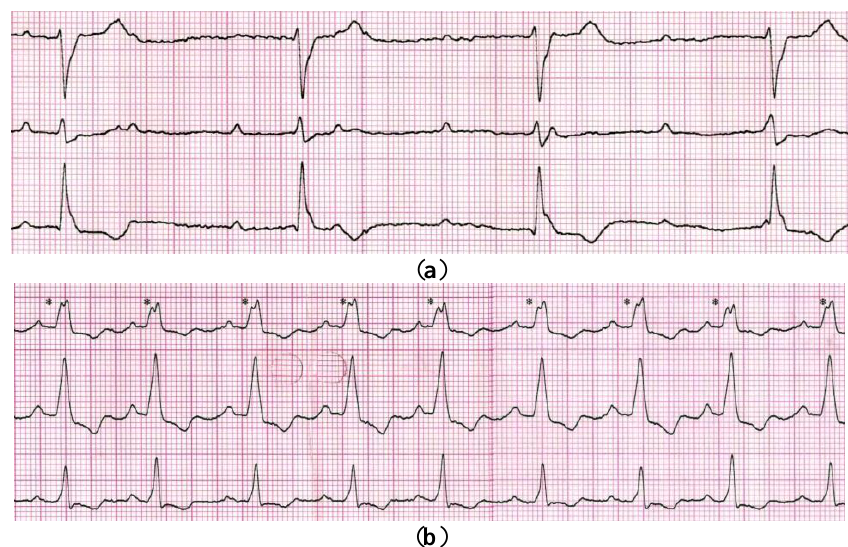
Figure 1. Electrocardiogram showing: ( a ) a sinus rhythm with complete heart block present at the admission time, and ( b ) a sinus rhythm with atrioventricular synchronous cardiac pacing obtained after a leadless AV pacemaker implantation (* - ventricular pacing impulses).